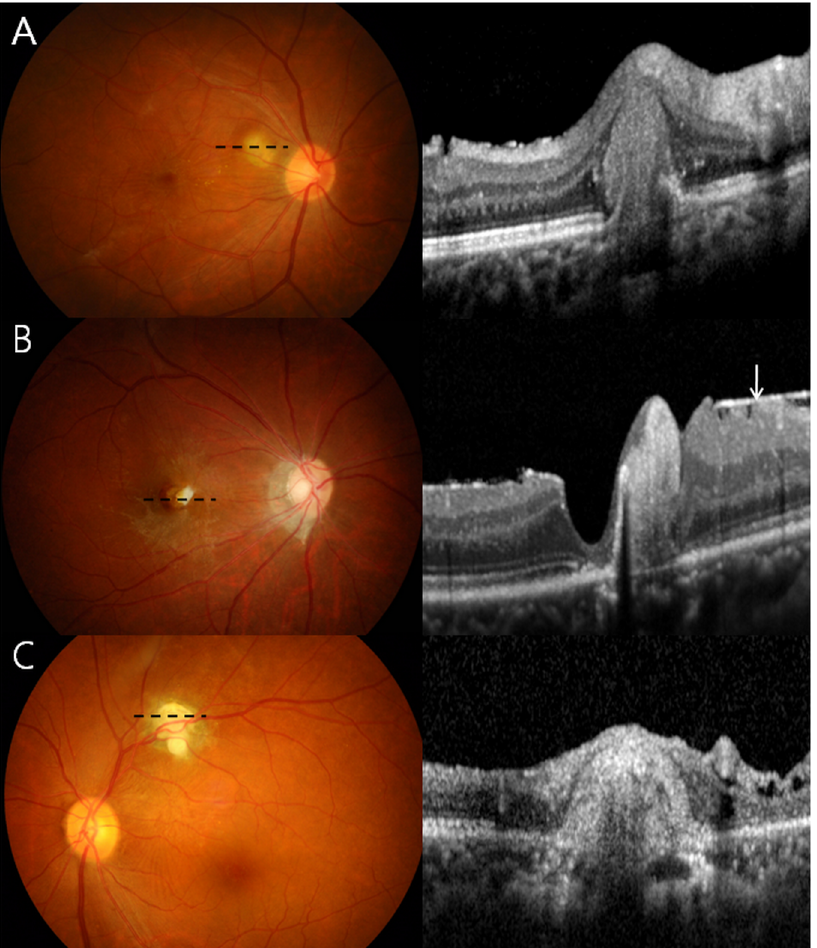
Figure 2. Spectral domain optical coherence tomography (SD-OCT) shows granulomas in the outer (A), inner (B), and all retinal layers (C) as reflective masses with posterior shadowing. The masses remarkably distort the retina and may be accompanied by the epiretinal membrane (B, arrow) and photoreceptor disruption (within two arrowheads). Dotted lines denote the scanned area.